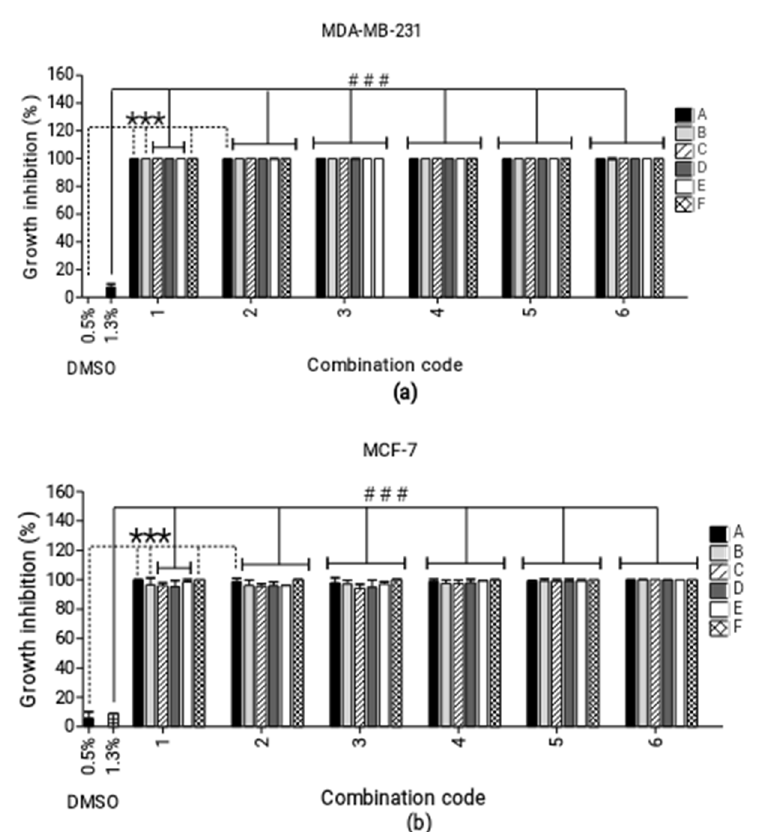
Figure 2. Screening of combinations consisting of four cannabinoids. Percentage growth inhibition induced by various ratios of four-cannabinoid combinations against the ( a ) MDA-MB-231 and ( b ) MCF-7 breast cancer cell lines. *** p < 0.0001 relative to 0.5% dimethyl sulfoxide (DMSO) vehicle control and ### p < 0.001 relative to 1% DMSO vehicle control. The four-cannabinoid combinations—i.e., A1–F6—are described in Figure 2.